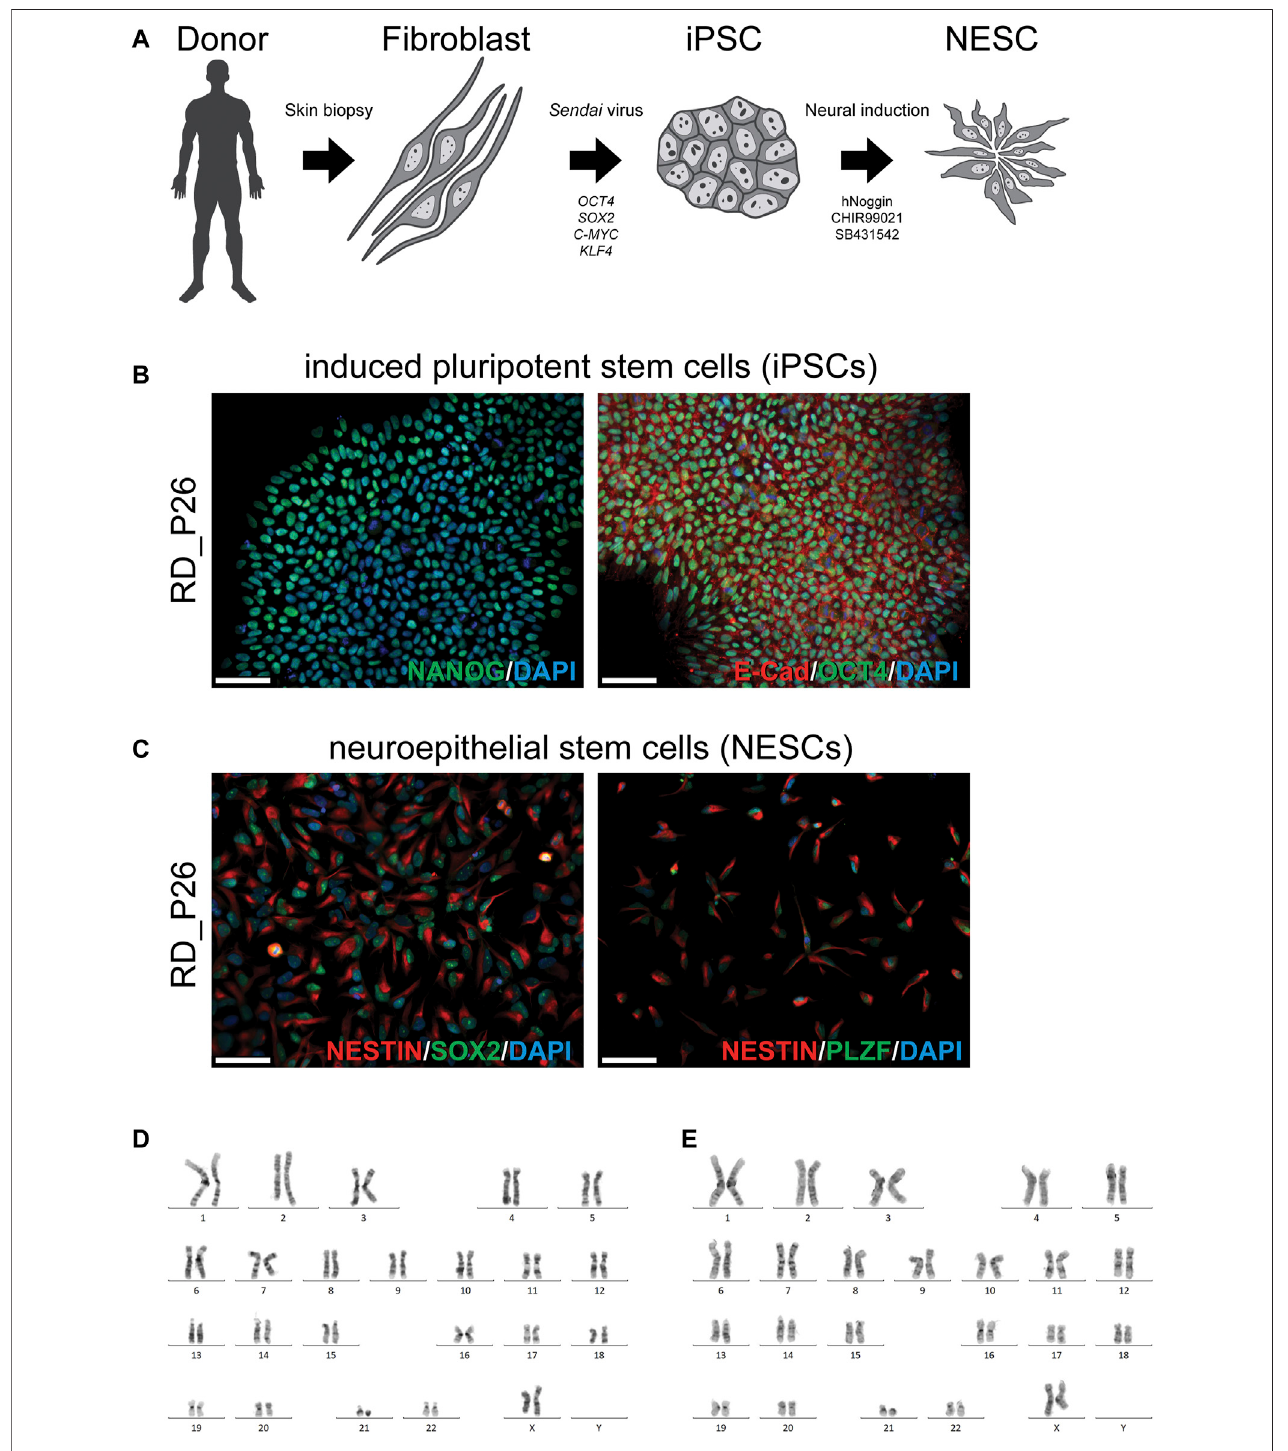
FIGURE1| Generationofapatientspeci fi ccellularmodelandcharacterizationofiPSCandNESClinesofRD_P26 (A) Fibroblastsareextractedfromthedonorand reprogrammed viaoverexpression ofthetranscriptionfactor OCT4 , SOX2 , C-MYC and KLF4 delivered Sendai virusvectors.After28days,iPSCswereneurally induced by supplementing the growth medium with hNoggin, CHIR99021 and SB431542. After 10 days post-induction rosette-like structures are observed (B) Patient iPSCs (RD_P26) used in this study expressing pluripotency markers E-Cadherin, OCT4 and NANOG (C) The iPSCs are neurally induced and give rise to neuroepithelial stem cells (NESCs) expressing neural speci fi c markers NESTIN, SOX2 and PLZF. Nuclei are stained with DAPI. Scale bar 50 µm (D, E) The patient cell lines were karyotyped showing an abnormal chromosome 21 in iPSCs (D) and NESCs (E) .